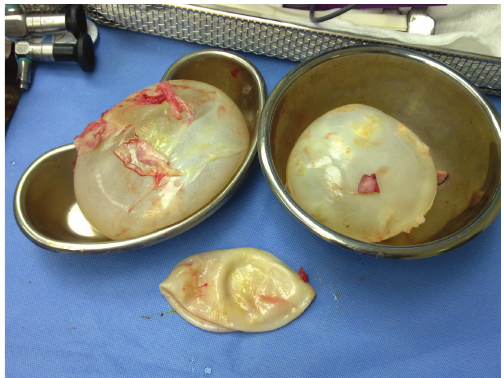
Figure 4: Postoperative removed three hydatid